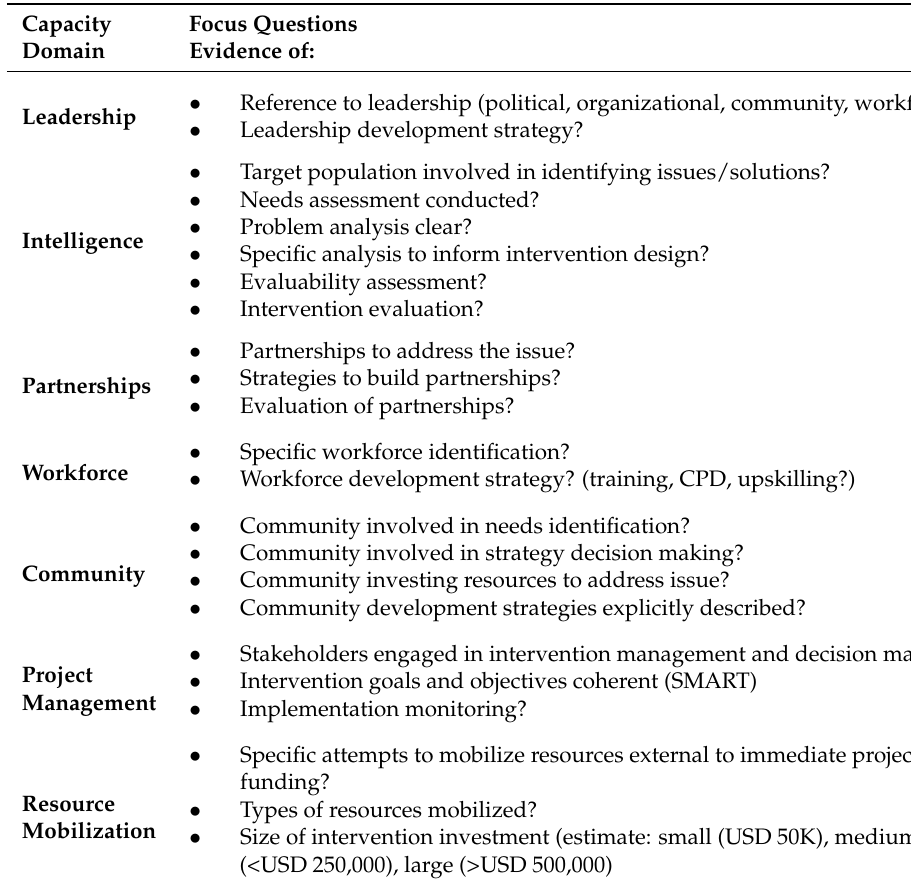
Table 1. Focus questions for the domains of capacity